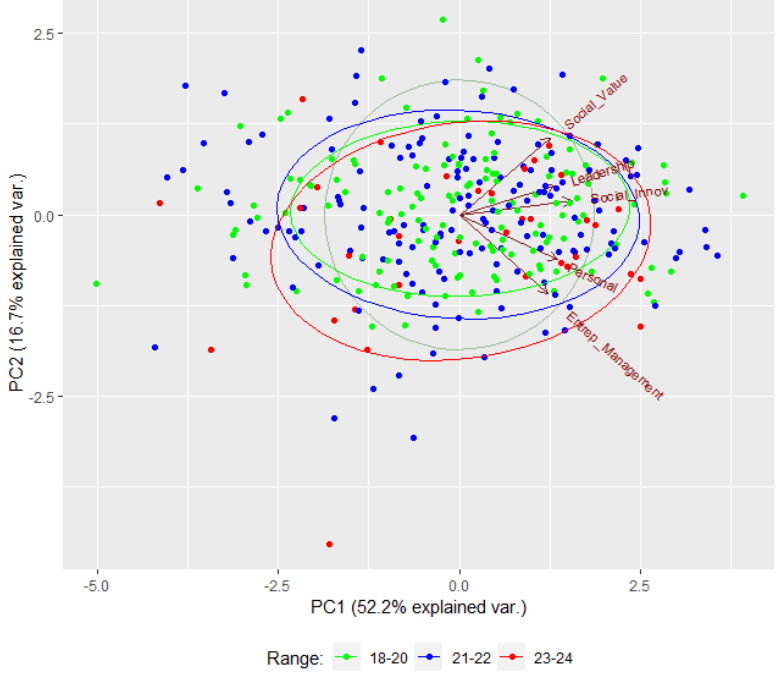
Figure 3. Principal Component BiPlot explaining 68% of the variability in our data. BiPlot of form ( α = 1). Source: Created by the